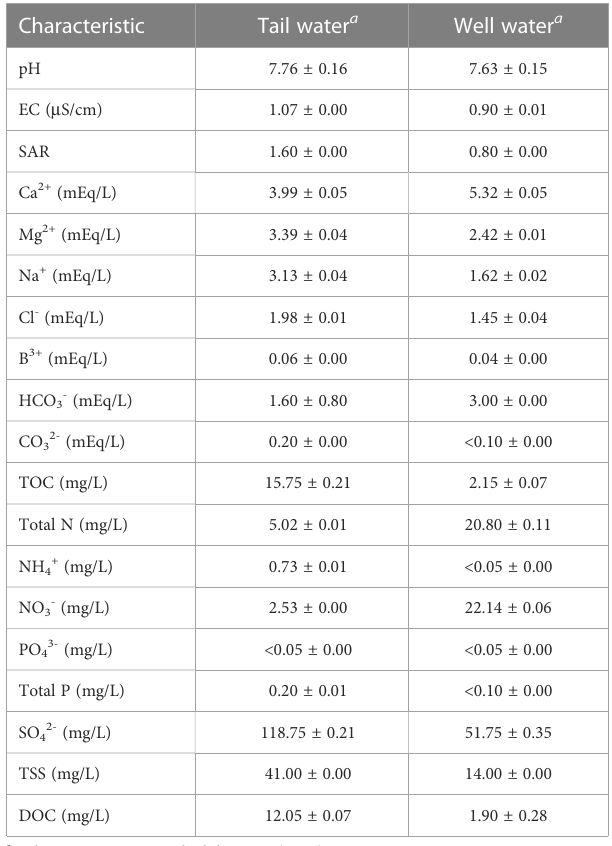
(Figure 2). A maximum 1.5-log reduction was observed for TV and MNV over 28 days (compared with day 0) when stored at 24°C (Figures 1, 2).